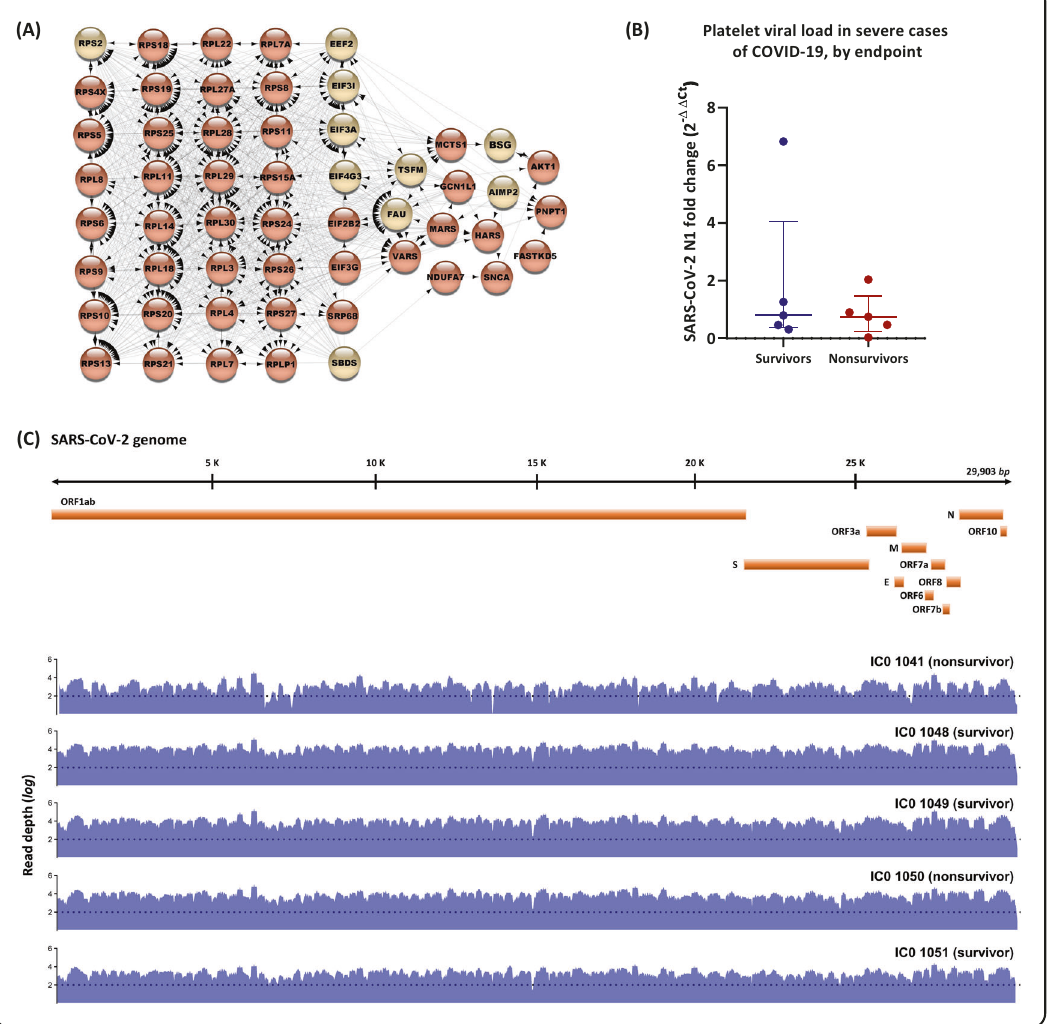
Fig. 5 Platelet infection by SARS-CoV-2. A PPI is related to mRNA translation and structural constituents of ribosomes. Circles in dark orange represent EPs from nonsurvivors; circles in light orange represent DEPs more abundant in the overall COVID-19 group. B Platelet viral loads in severe cases of COVID-19, by endpoint: survivors or nonsurvivors. No signi fi cant differences were found between endpoints (Mann – Whitney U = 11, P = 0.8413, ns). C SARS-CoV-2 genome coverage graphs of platelet samples. Platelet RNA was submitted to SARS-CoV-2 target sequencing to screen for viral genome presence, whether total or partial. A scheme of the Wuhan-Hu-1 genomic isolate [GenBank: NC_045512.2], spanning all structural and nonstructural components, is represented with coverage graphs (blue) for each sample [GenBank: OL984052; OL984053; OL986402; OL984057; OL984061]. Dotted lines mark read depths equal to 100. was upregulated in platelets isolated from patients during clinical gene-15 (ISG-15) as differentially abundant in critically ill patients. infections of in fl uenza and dengue virus; due to some modi fi ca- The expression of ISG-15 is strongly associated with an antiviral tion, there is a lower expression in platelets, and there is an response, reducing viral replication, minimizing the externalization increase in disease severity and mortality in patients. Infection of of virions, and acting as a chemotactic cytokine for neutrophils human MKs with DENV selectively increased type I and IFITM3 [44]. Recently, a multiomics analysis in a model of severe COVID-19 interferons, and overexpression of IFITM3 was suf fi cient to prevent also highlighted the importance of ISG-15 in the overall antiviral response, particularly in the lungs [45]. The same phenomenon has already been observed when infecting the megakaryocyte cell line MEG-01 with dengue virus and observed an increase in the expression of ISG-15, which is important in the antiviral response The clinical progression of COVID-19 can be highly variable [46]. The recruitment of other interferon-induced protein families among individuals, ranging from mild, asymptomatic infections to [tetratricopeptide repeat proteins (IFITs) and IFN-induced trans- severe respiratory distress. Accordingly, the molecular background membrane proteins (IFITMs)] was also highlighted by our data. of each patient plays a signi fi cant role in determining the disease Brie fl y, these protein families are involved in translation initiation, outcome [48]. In this context, we classi fi ed the severe COVID-19 virus replication, double-stranded RNA signaling, cell migration, patients according to their clinical outcomes (survivors/nonsurvi- and proliferation [24] and signi fi cantly in fl uence the disease vors) and compared their proteomic datasets. Notably, the DEPs/ progression and outcome of several viral infections [47]. IFITM3 Cell Death Discovery (2022)